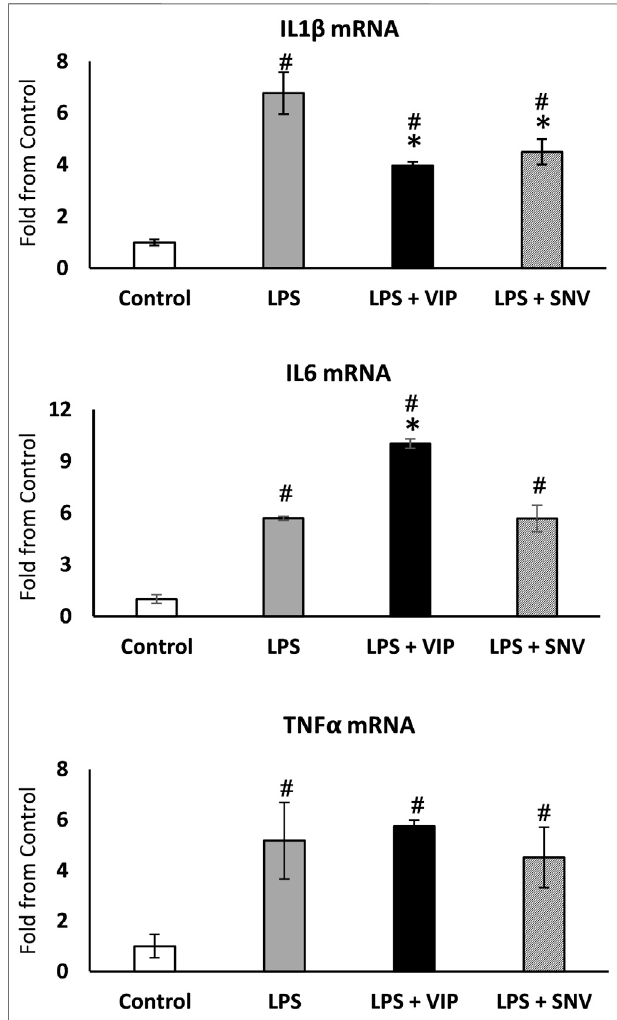
FIGURE 2 | VIP and SNV displayed a partial anti-in fl ammatory effect in LPS-stimulated macrophage cultures. Primary murine macrophages were treated with 10 -6 M of VIP or SNV (or saline) and exposed to 1 µg/ml LPS for 24 h. Expression of IL1 β , IL6 and TNF α was examined using RT-qPCR and presented as fold from untreated controls (no LPS). n (cid:2) 5, # p < 0.05 vs. Control; * p < 0.05 vs. LPS, 1-way